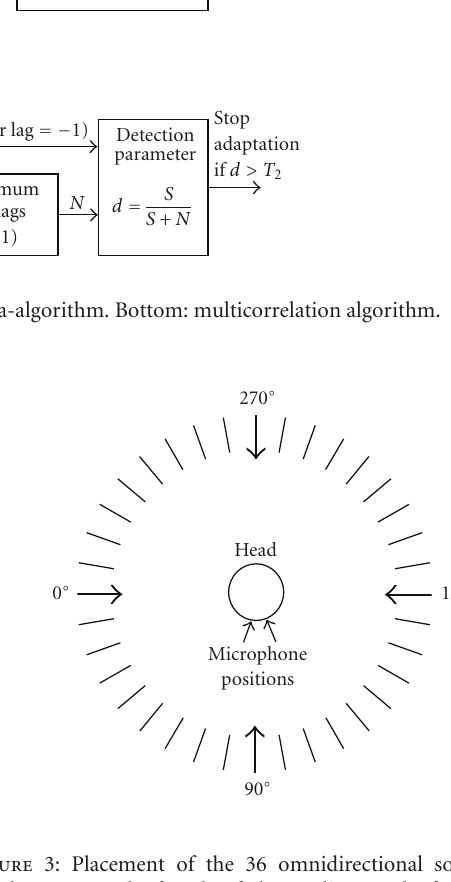
Figure 3: Placement of the 36 omnidirectional sound sources (at the outer end of each of the 32 lines and of the 4 arrows marked 0 ◦ to 270 ◦ ) and of the two microphones (on the surface of the head, intermicrophone distance 7 mm) in the simulated acoustic environments used to evaluate the target signal detection